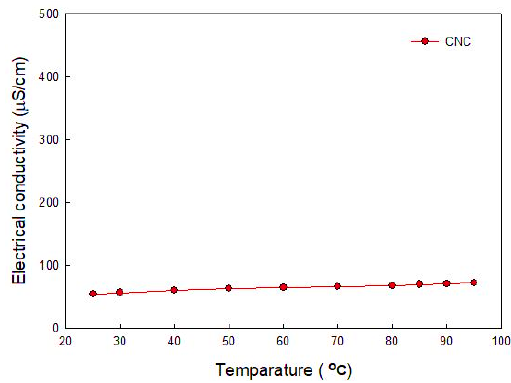
Figure 4. Electrical conductivity of CNC with increase in temperature.